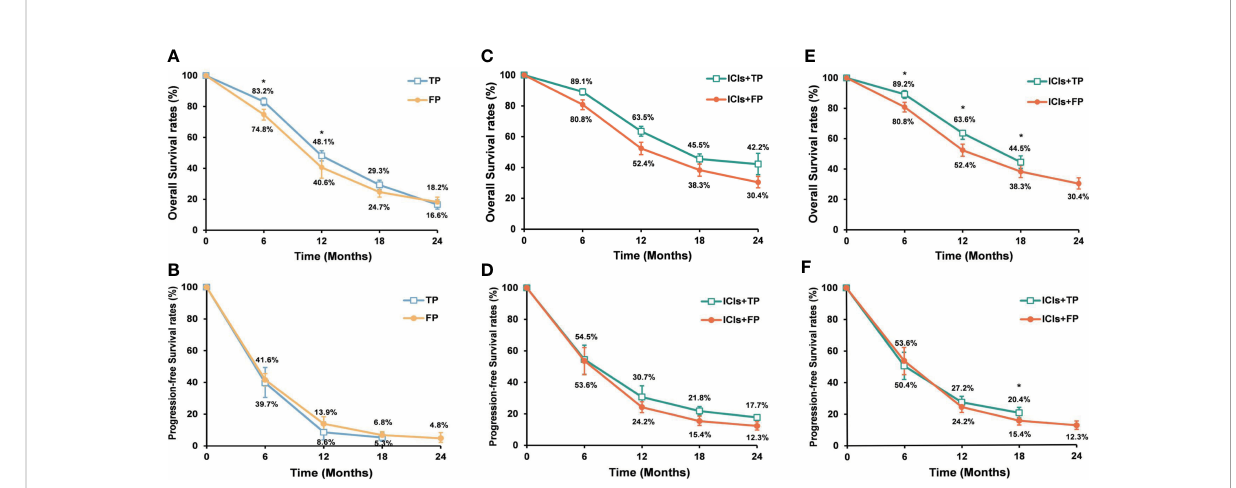
FIGURE 4 Pooled OS rates (A) and PFS rates (B) of the TP and FP groups when 5 RCTs were included. Pooled OS rates (C) and PFS rates (D) of the ICIs+TP and ICIs+FP groups when 5 RCTs were included. Pooled OS rates (E) and PFS rates (F) of the ICIs+TP and ICIs+FP groups when the ORIENT-15 trial was excluded from the 5 RCTs. OS, overall survival; PFS, progression free survival; ICIs, immune checkpoint inhibitors; TP, taxane plus platinum; FP, fl uorouracil plus platinum; RCTs, randomized controlled trial. *TP versus FP or ICIs+TP versus ICIs+FP,